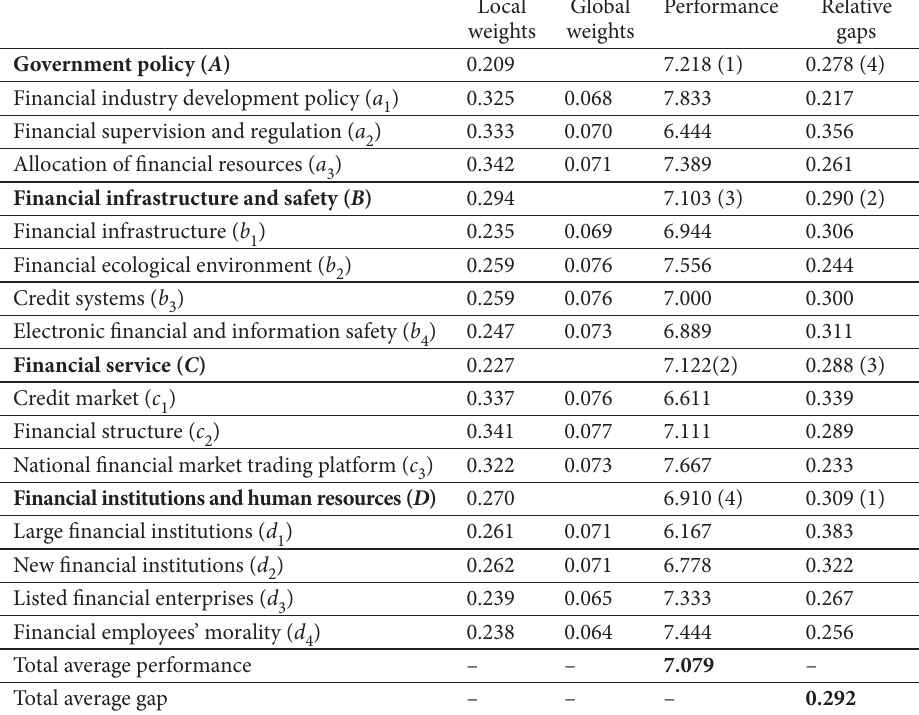
Table 9. Integrated index of financial center modernization dimensions and